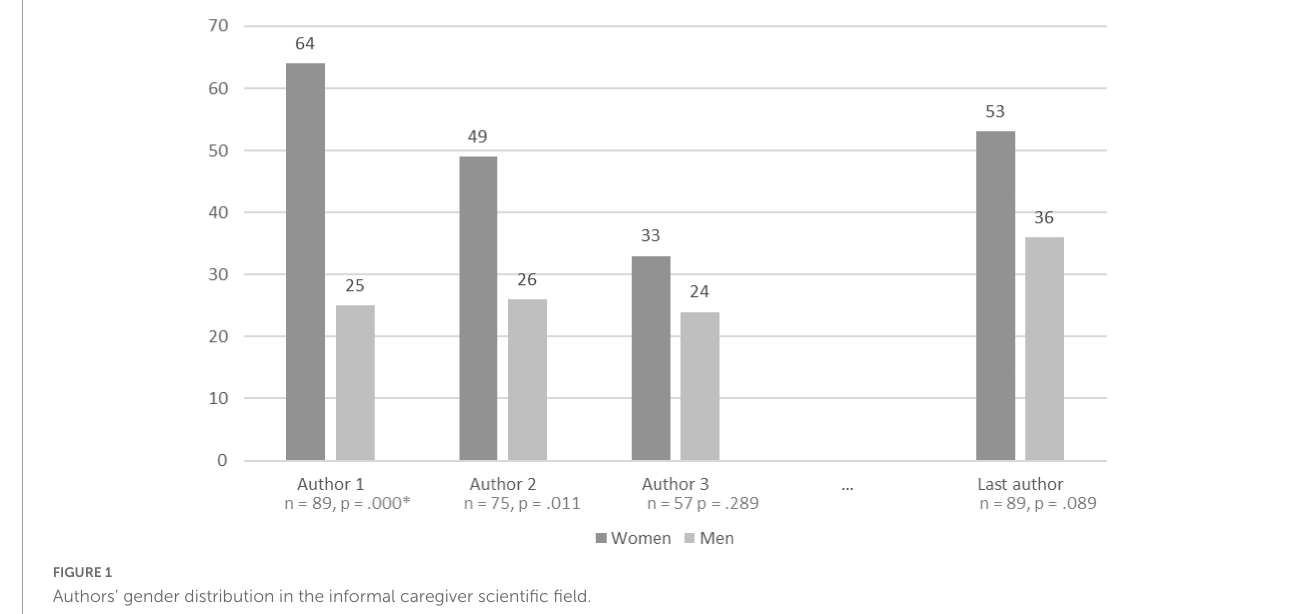
FIGURE1 Authors’ gender distribution in the informal caregiver scientific field.